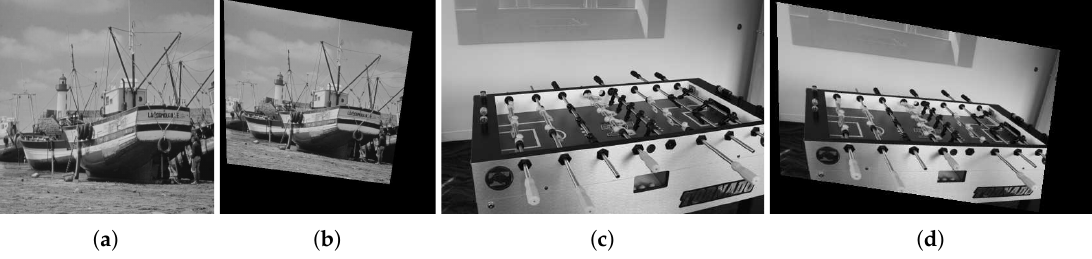
Figure 10. Boats image pair and Foosball image pair. ( a ) Boats reference image. ( b ) Boats sensed image. ( c ) Foosball reference image. ( d ) Foosball sensed